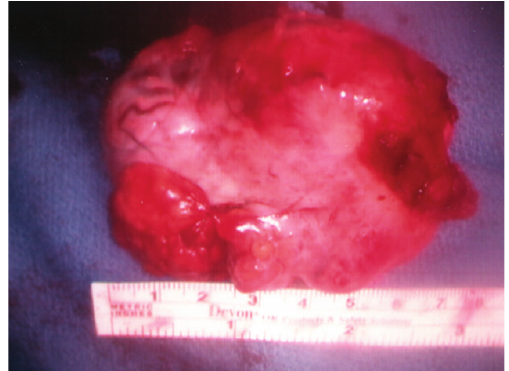
Figure 1: Gross specimen of right ovary with attached benign testosterone producing germ cell tumor ultimately diagnosed as steroid cell, not otherwise specified.